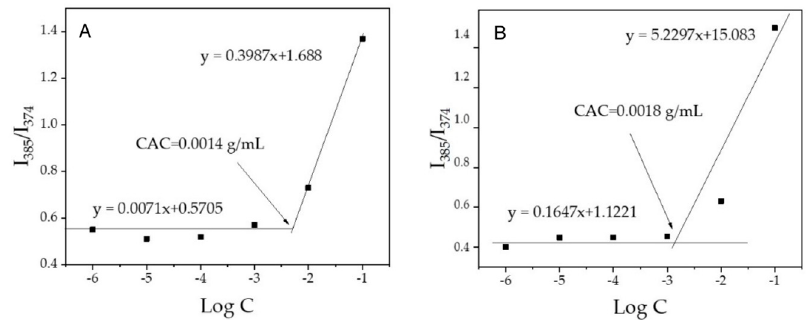
Figure 1. Measurement of the CAC via the pyrene fluorescence probe method; ( A ) CP1 and ( B ) CP2 . The average particle size and size distribution are also important parameters for drug self-delivery systems. The hydrodynamic size and size distribution of the CP1 and CP2 NPs were evaluated via DLS at a concentration higher than the CAC, i.e., 0.1 mg mL − 1